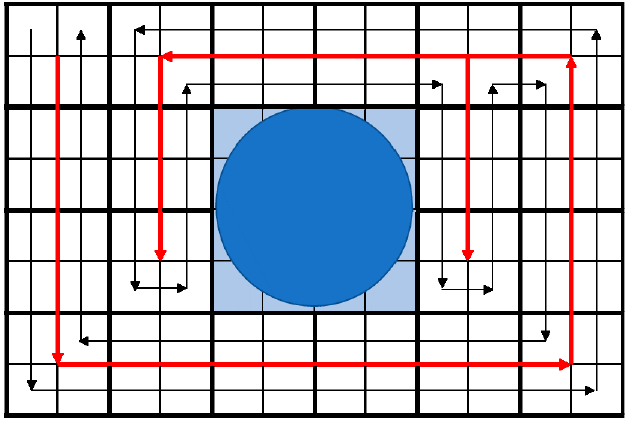
Figure 1. Coverage Path Planning with Spiral Spanning Tree Coverage (STC).